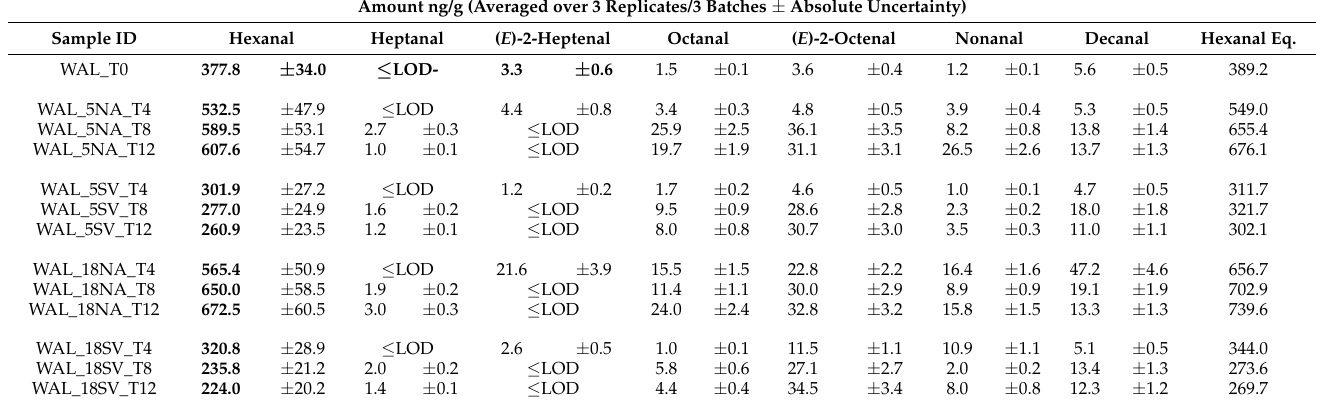
Table 4. Amounts expressed as ng/g for quantified targeted aldehydes in walnut samples. In bold analytes whose concentration exceeds the OTs (OAV > 1).